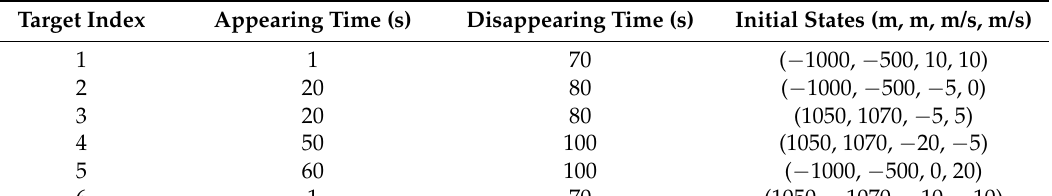
Table 1. A List of Initial Target States.